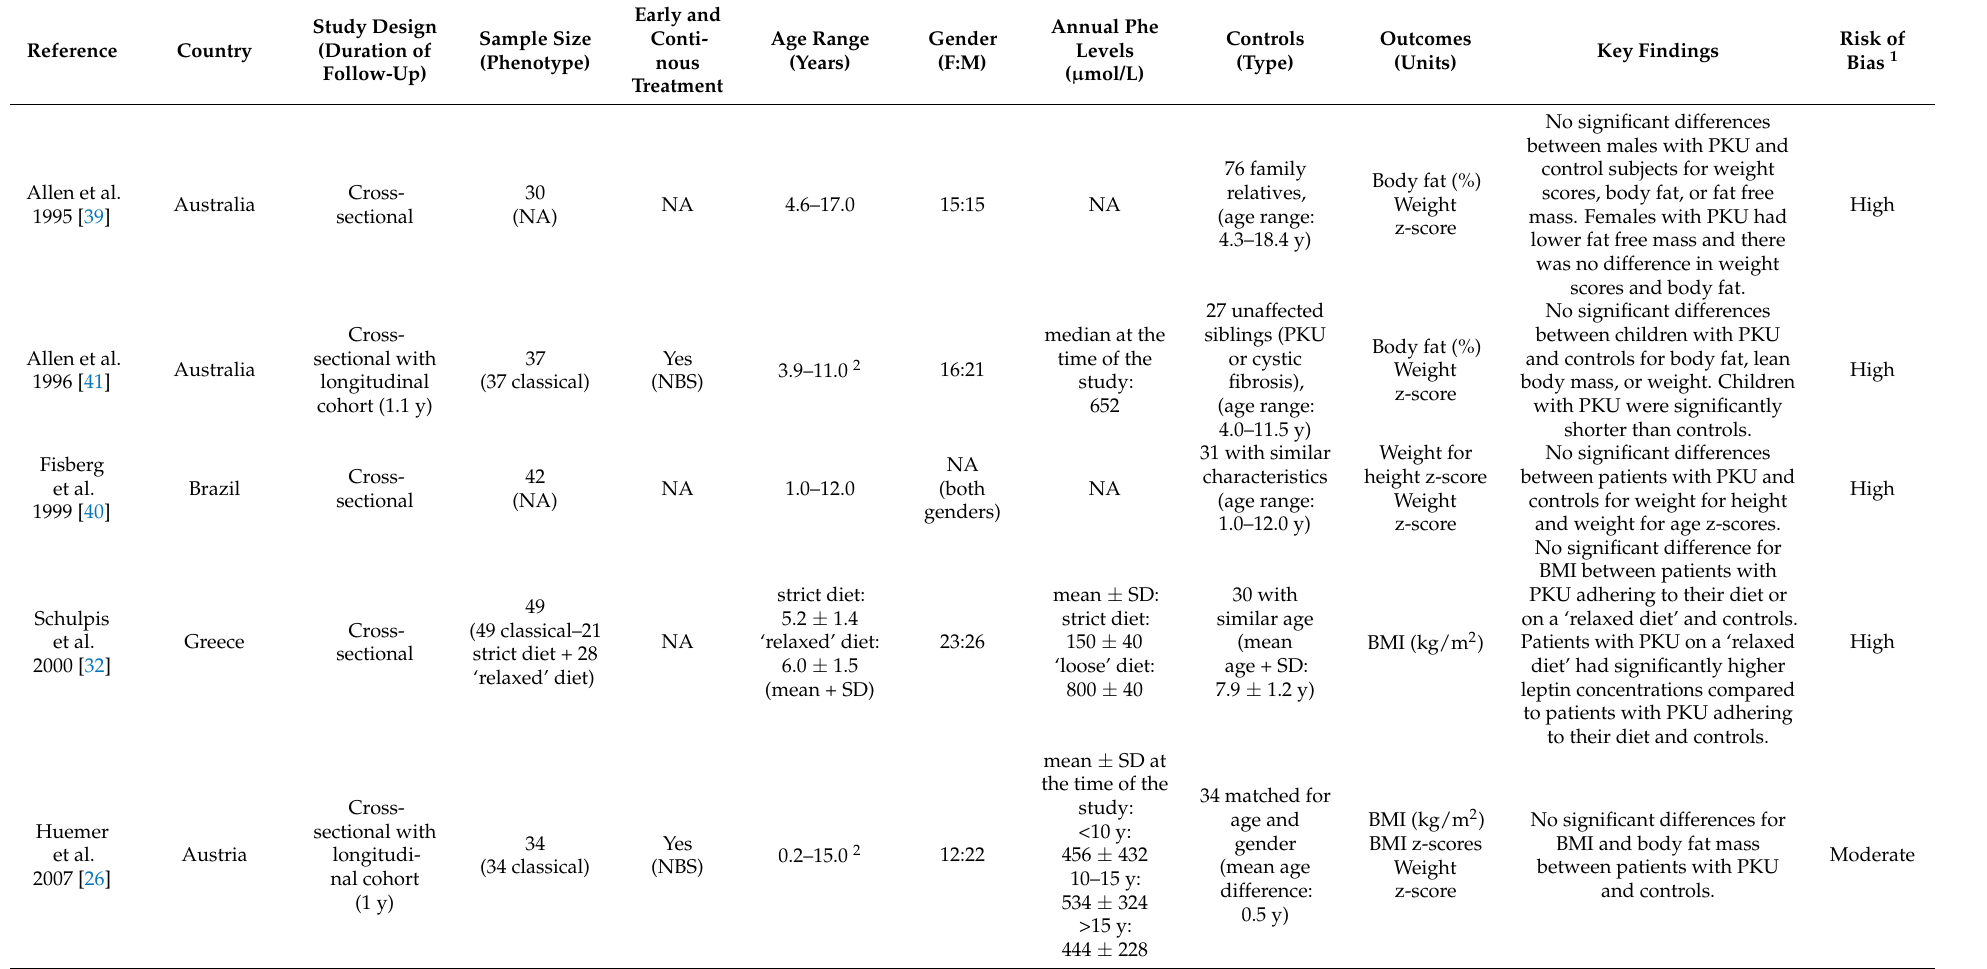
Table 1. Characteristics of the studies included in the systematic